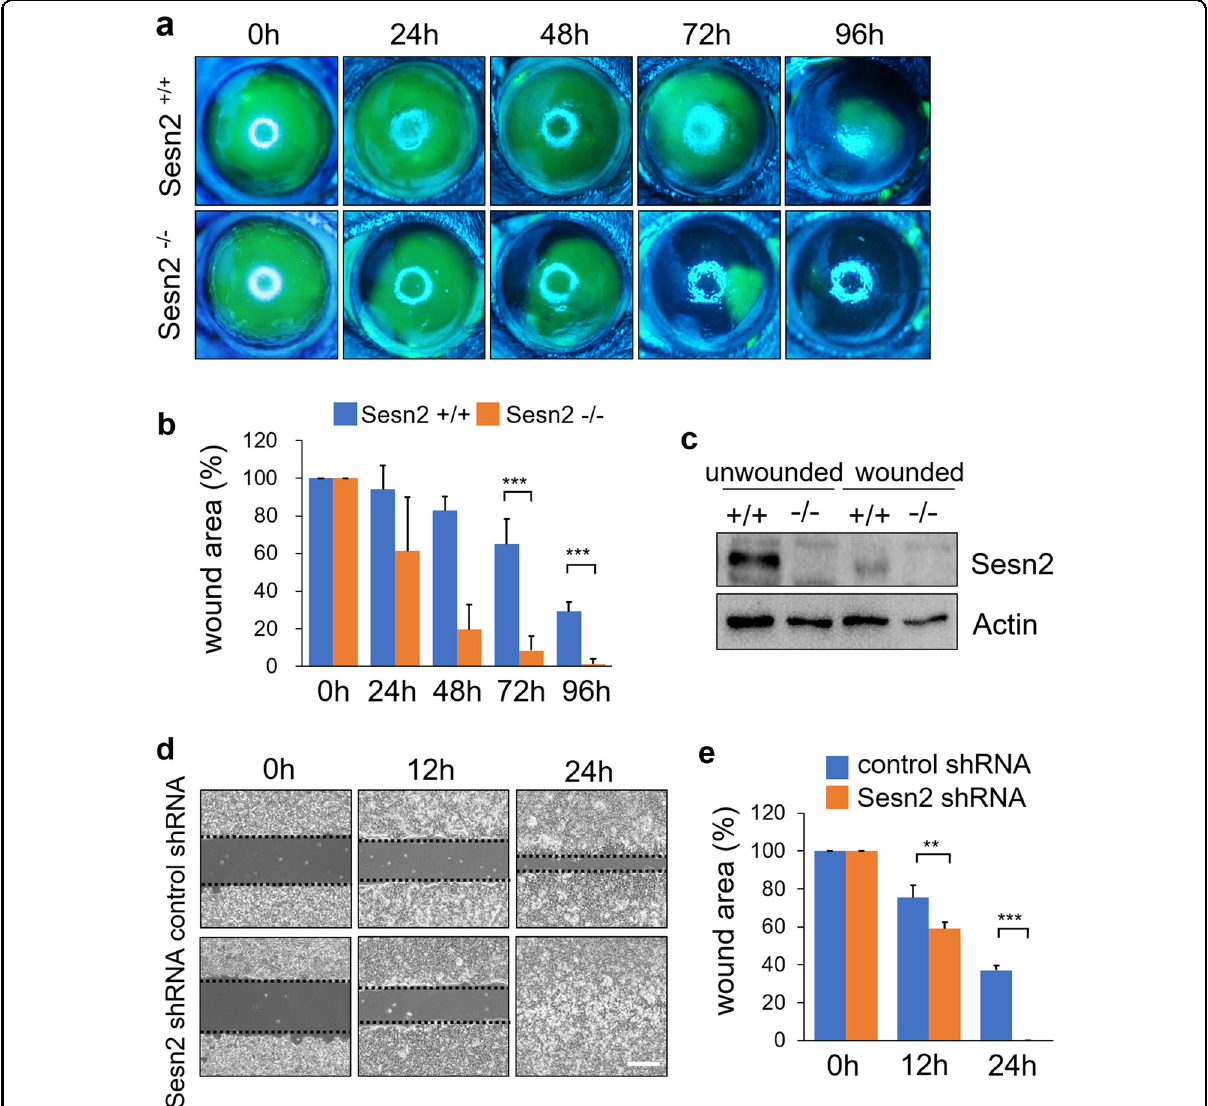
Fig. 1 Sesn2 de fi ciency enhances corneal wound healing. a Representative photographs of the fl uorescein-stained corneas of Sesn2 − / − and Sesn2 + / + mice at 0, 24, 48, 72, and 96 h after injury using a 2.5 mm punch. The fl uorescein-stained area represents the corneal epithelial wound area. By 96 h, the corneal wound area in Sesn2 − / − mice was healed, whereas that of Sesn2 + / + mice remained open. b Quantitative analysis of the corneal wound area of Sesn2 − / − and + / + mice. A total of 12 eyes from Sesn2 − / − and Sesn2 + / + mice were used to measure the epithelial wound area size. The wound area was signi fi cantly smaller in Sesn2 − / − mice than in Sesn2 + / + mice. c Corneal tissues from Sesn2 − / − and Sesn2 + / + mice were lysed 48 h after injury and subjected to western blotting with Sesn2 and actin antibodies. d In vitro wound healing assays of hCET cells expressing Sesn2 shRNA and control shRNA. hCET cells expressing Sesn2 shRNA or control shRNA were seeded on both sides of a wound chamber and allowed to attach for 12 h. The chamber was removed, and the wound areas were photographed immediately at 0, 12, and 24 h. Dotted lines indicate wound borders at the beginning of the assay. e Quantitative analysis of the wound areas of hCET cells expressing Sesn2 shRNA and control shRNA at 0, 12, and 24 h. The rate of wound closure in hCET cells expressing Sesn2 shRNA was signi fi cantly higher than in hCET cells expressing control shRNA. Error bars represent the means ± SD of three independent experiments. Two-tailed Student ’ s t -test (** p < 0.01, *** p < 0.001). Scale bar, 300